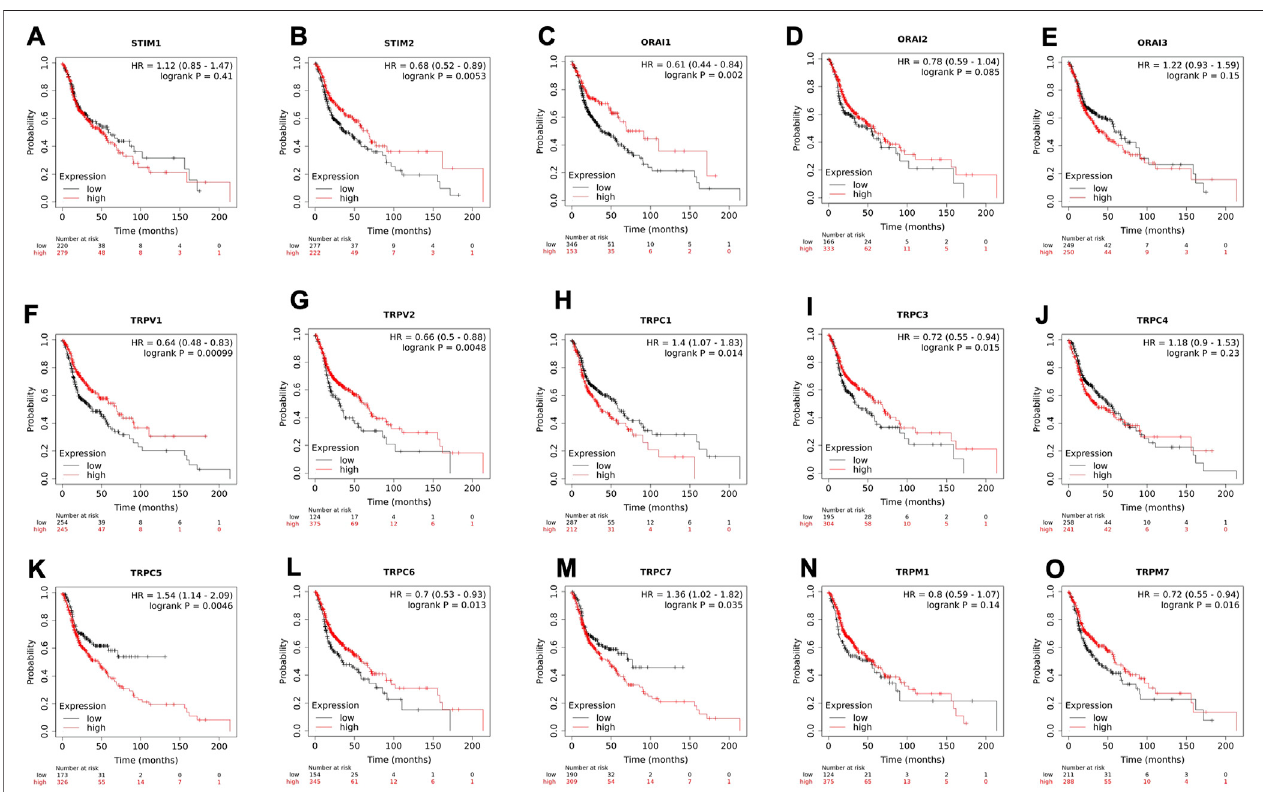
FIGURE6| Thealtered expression ofSOCs resulted inpoorsurvivalofHNSC patients. (A-O) Kaplan-meier plot foralltheSOCsexpression inHNSC patients was downloadedfromKMplotter.Theprobabilityofsurvivalforhighandlowexpression areshown.Inset-Hazardratio(HR)with95%con fi denceintervalandlogrank p value are mentioned. The number of patients at risk during the time interval is given below the